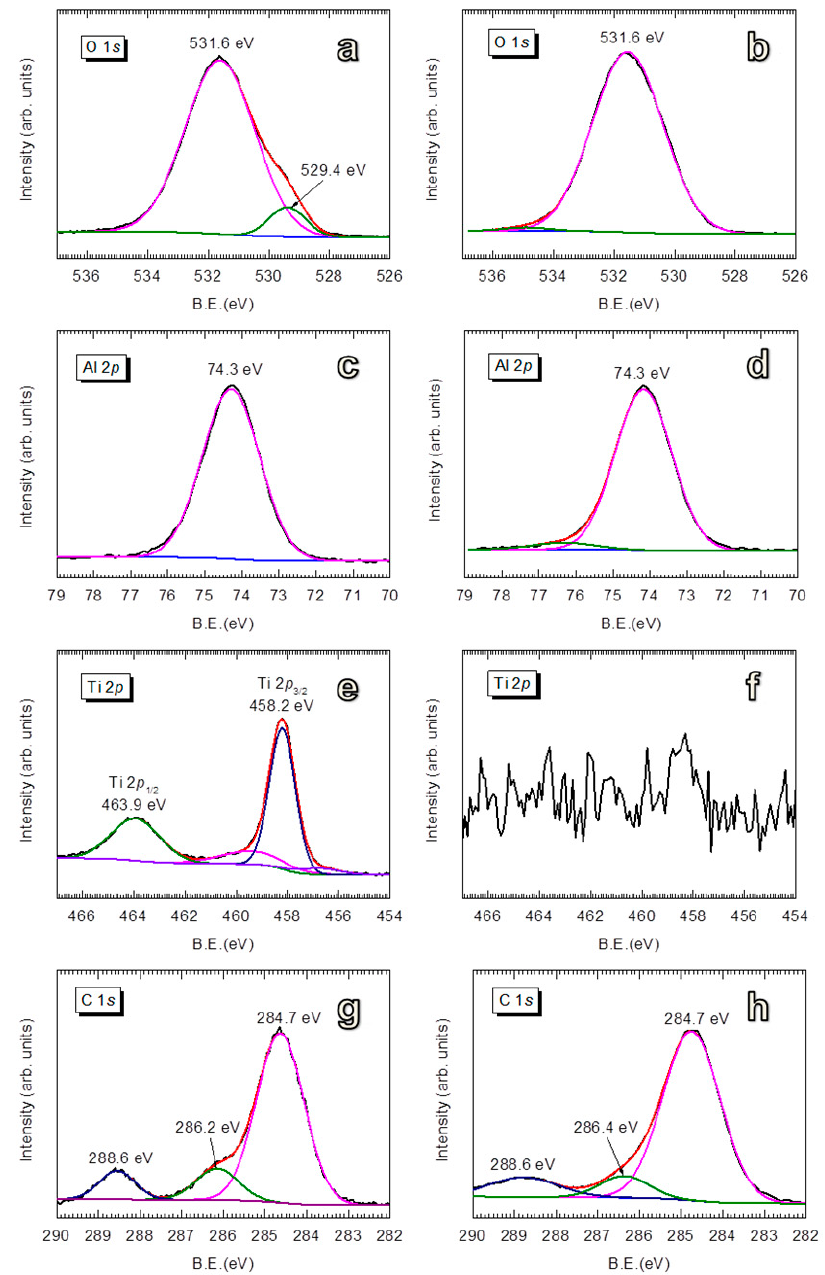
Figure 3. XPS spectra of anatase TiO 2 coated with 3 nm thick ( a , c , e , g —on the left side) and 5 nm thick ( b , d , f , h —on the right side) Al 2 O 3 films.